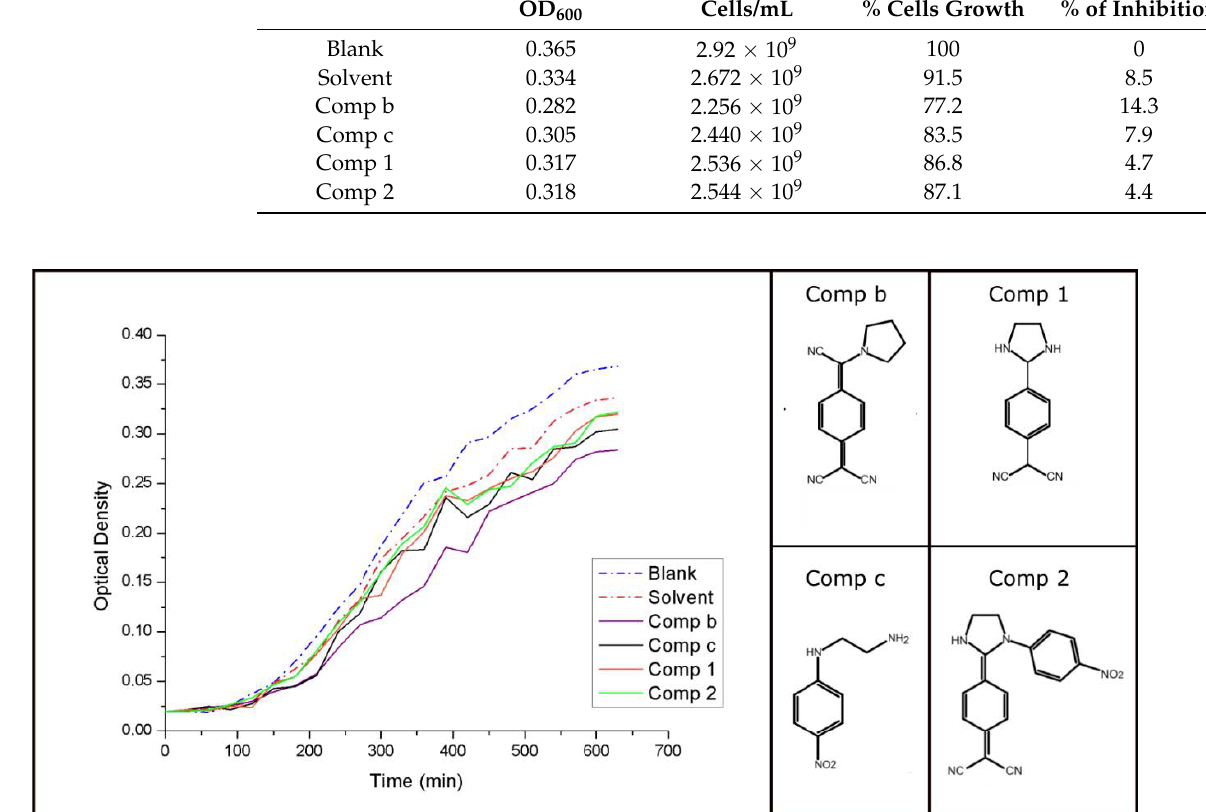
Figure 5. Growth curves for the OD 600 tests performed to five different test tubes, blank (growth curve under standard conditions); Solvent (growth curve under the presence of the used solvent 5:5 water/DMSO); Comp.b (growth curve under the presence of PTCNQ) ); Comp.1 (growth curve under the presence of compound 1 ); Comp.2 (growth curve under the presence of compound 2 ); Comp c (growth curve under the presence of compound